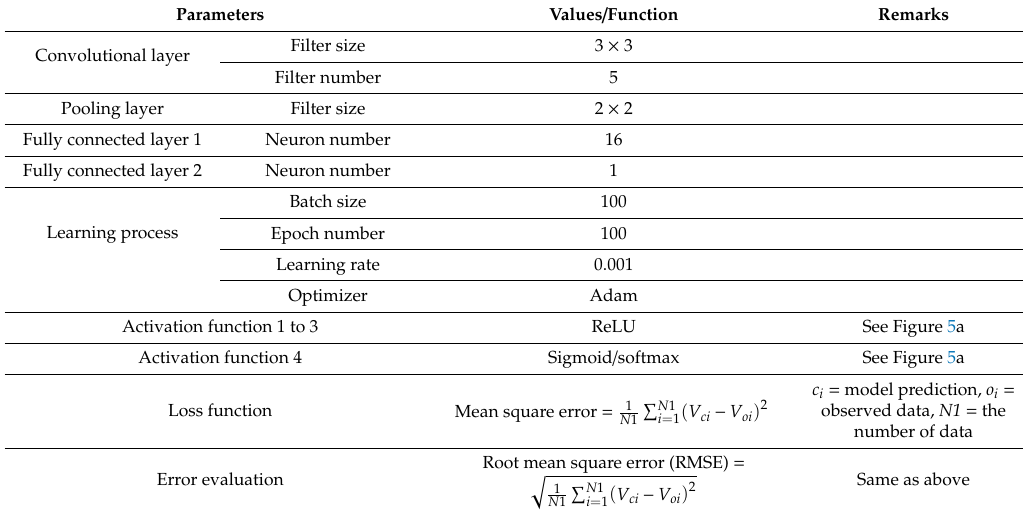
Table 6. Setups of CNN parameters and